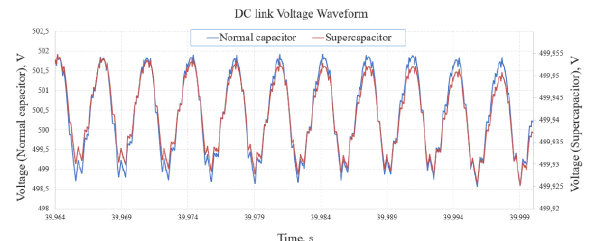
Figure 4. Voltage in the DC link of frequency converter